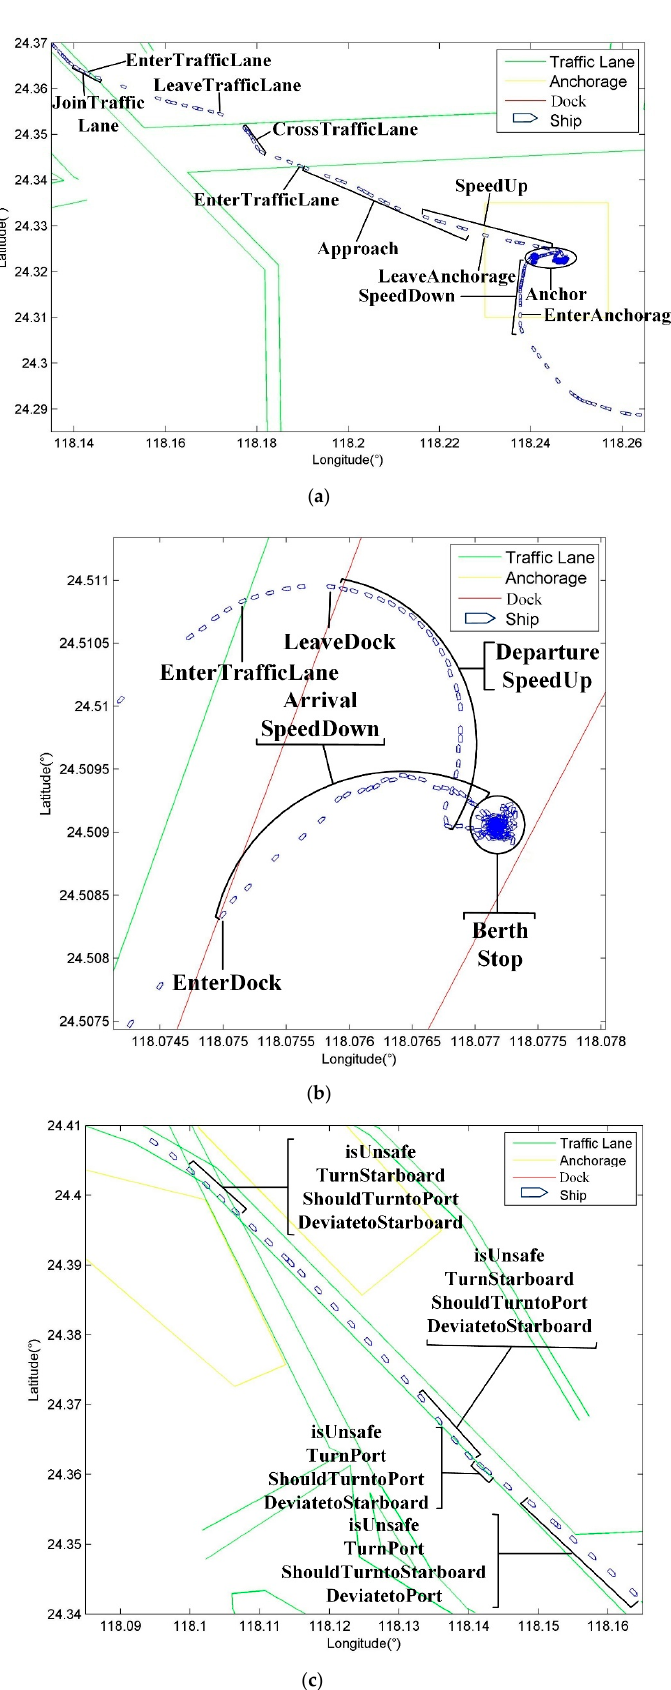
Figure 14. Semantic annotation of ship behavior in typical scenes of harbor. ( a ) The ship around the anchorage; ( b ) the ship near the dock; and ( c ) the ship in the traffic lane.